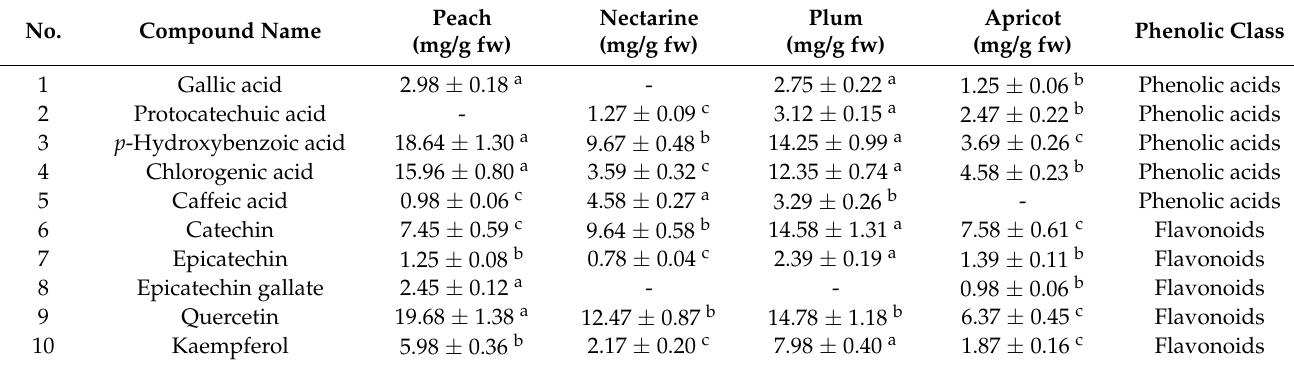
Table 4. Quantification of phenolic compounds in stone fruits waste samples by HPLC-photodiode array detection (PDA).